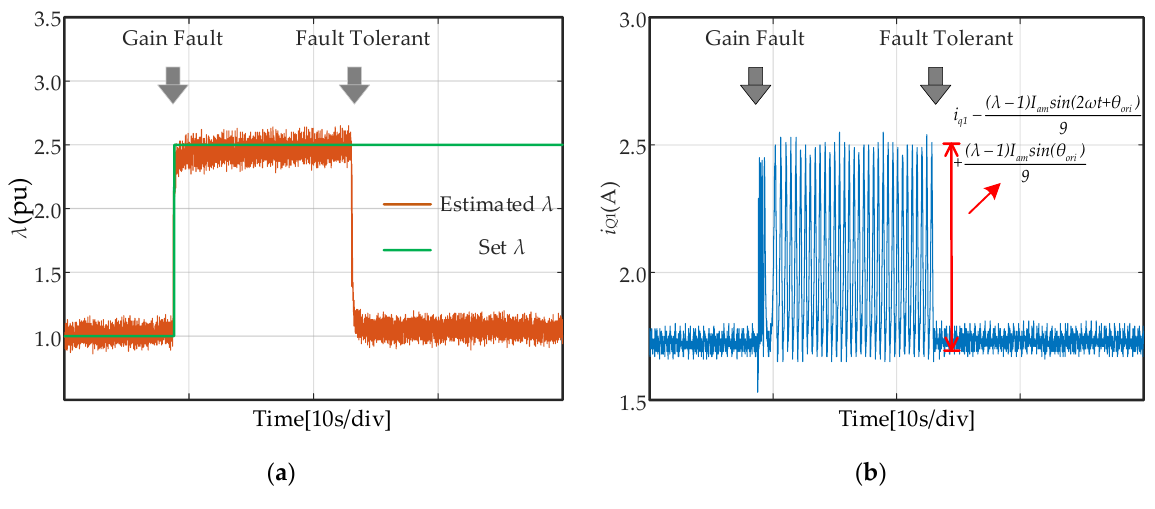
Figure 16. ( a ) Estimated λ and set λ ; ( b ) i Q 1 .